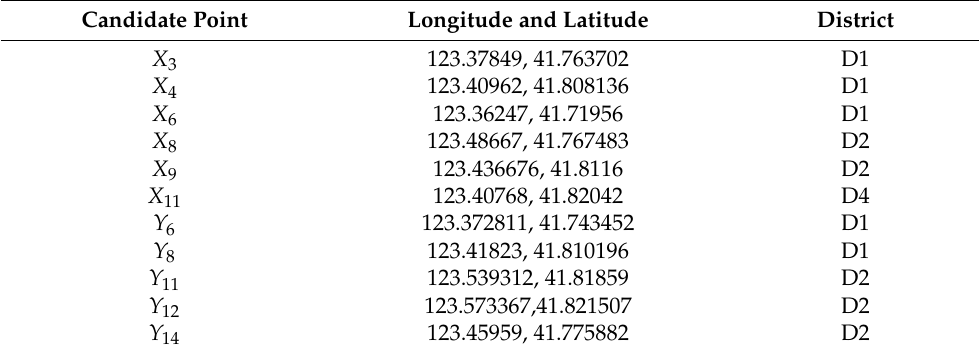
Table 10. The optimal location of candidate